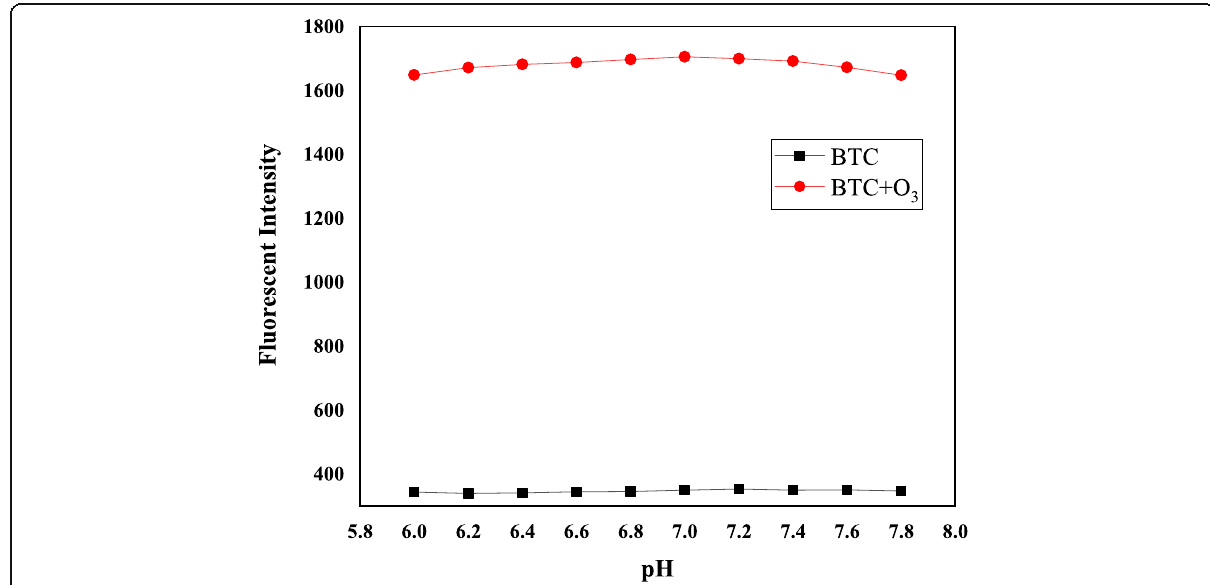
Fig. 4 Response of probe BCT (10 μ M) to O 3 (25 μ M) under different pH